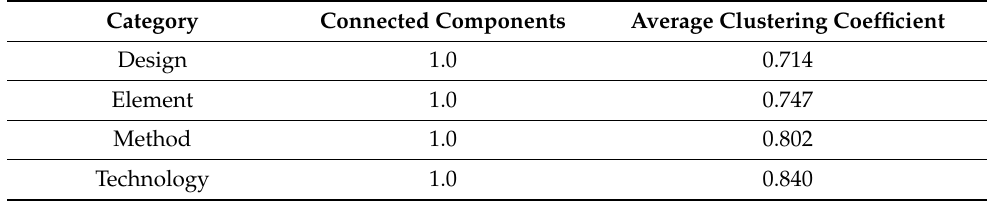
Table 2. Connected components and average clustering